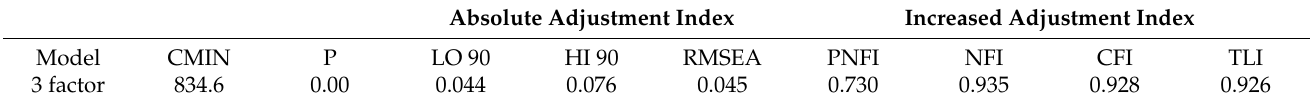
Table 1. Model adjustment index of Educational Career Guidance Tool for Pre-University Student Questionnaire (EGPUQ). Absolute Adjustment Index Increased Adjustment Index